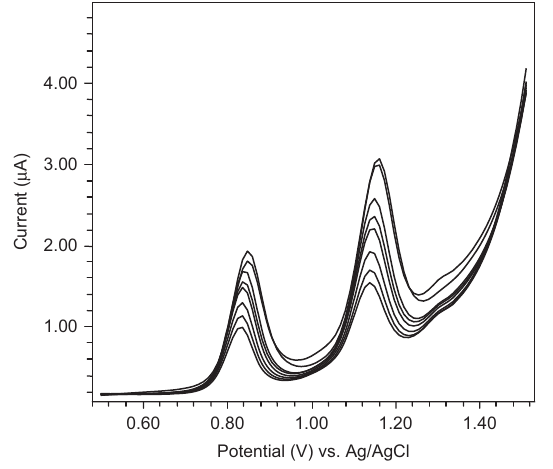
concentrations of ds-DNA in 0.2 m acetate buffer (pH 7.0 ± 0.01) at multi-walled carbon nanotube paste electrode (MWCNTPE), pulse amplitude 50 mV, scan rate 50 mVs -1 , current range 10 μ